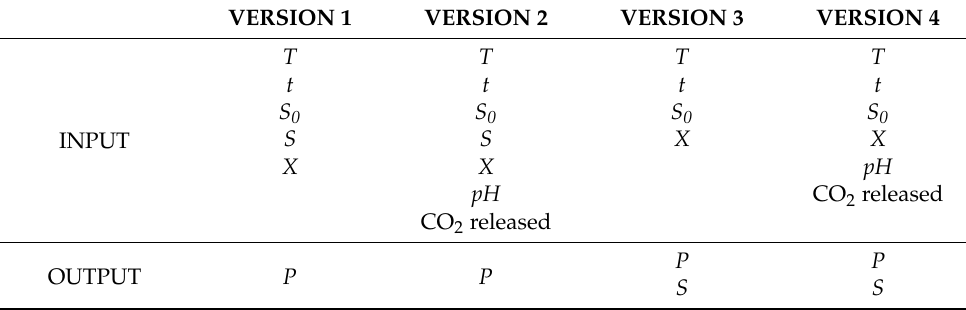
Table 1. The four types of NN simulated (input & output